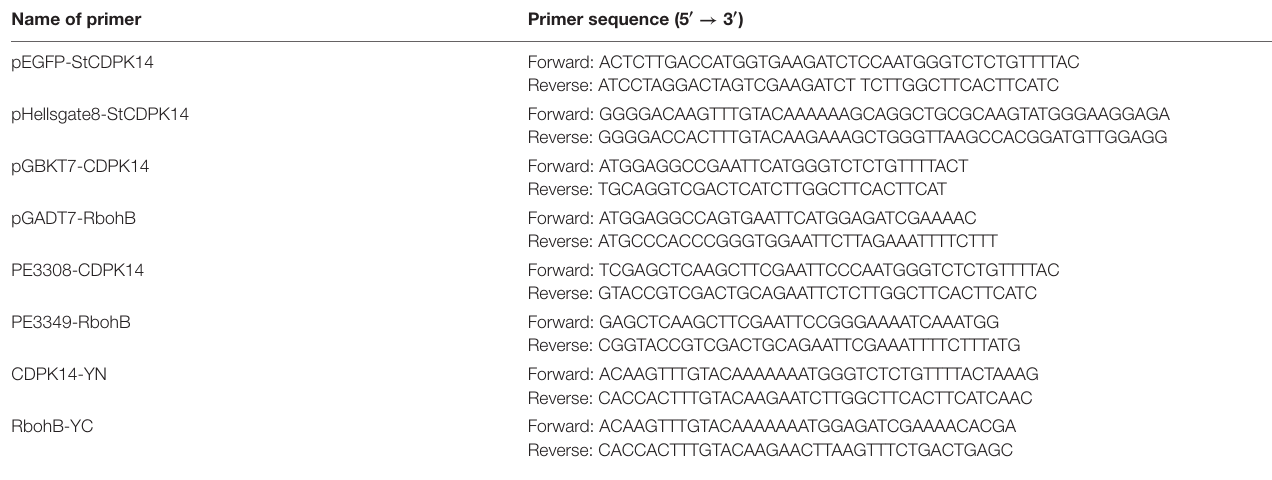
TABLE 2 | Primer sequences used in subcellular localization, transgenic plant, yeast-two-hybrid, and bimolecular fluorescent complimentary